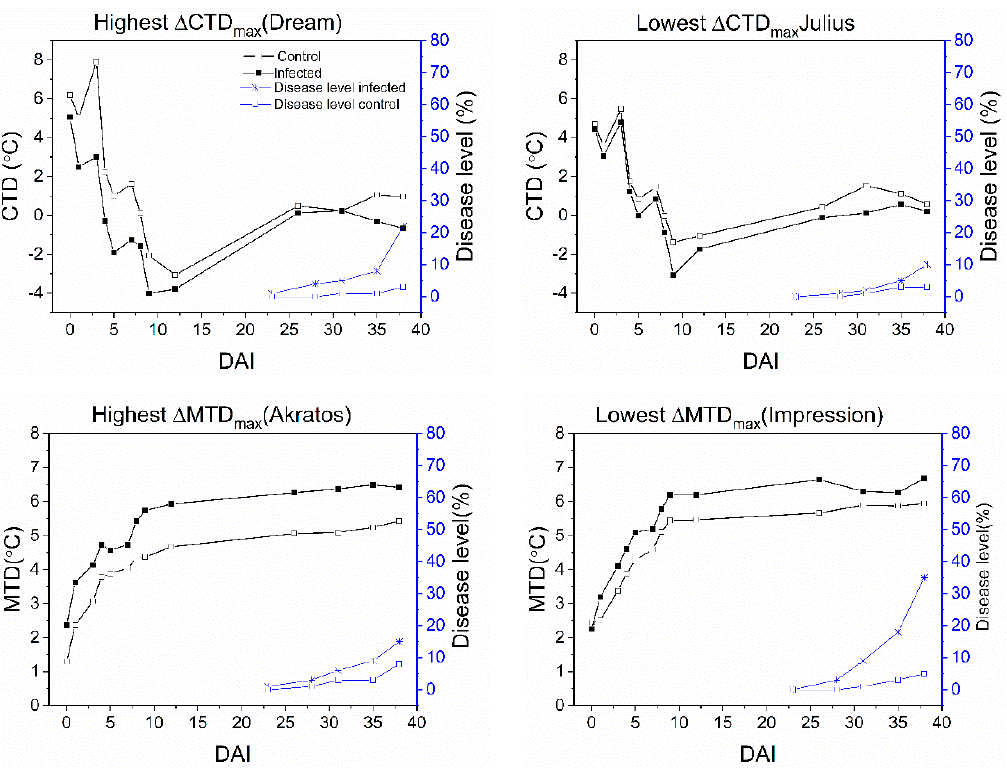
Figure 4. E ff ects of Z. tritici inoculation on Canopy Temperature Depression (CTD), Maximum Figure 4. Effects of Z. tritici inoculation on Canopy Temperature Depression (CTD), Maximum Temperature Di ff erence (MTD), Crop Water Stress Index (CWSI) and disease Temperature Difference (MTD), Crop Water Stress Index (CWSI) and disease level.